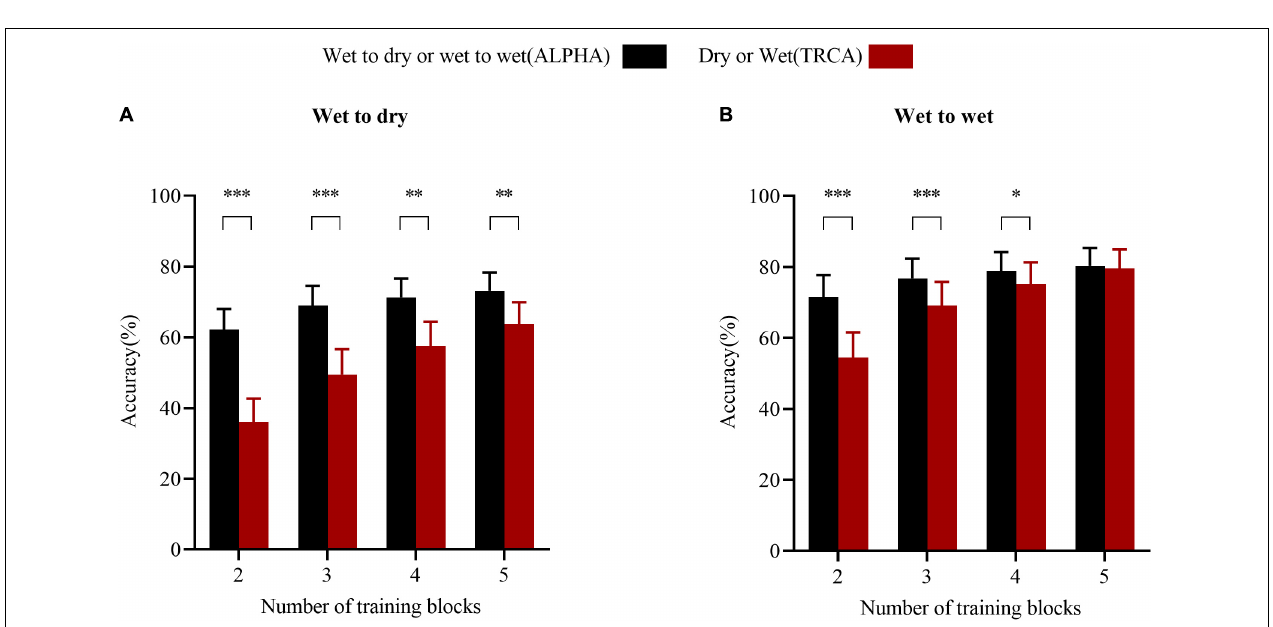
FIGURE 8 | The performance comparison of the ALPHA and TRCA methods for different numbers of training blocks. (A) Accuracy. (B) Accuracy. The error bars indicate standard errors. The asterisks indicate a difference in the paired t -test results (* p < 0.05, ** p < 0.01, and *** p < 0.001).